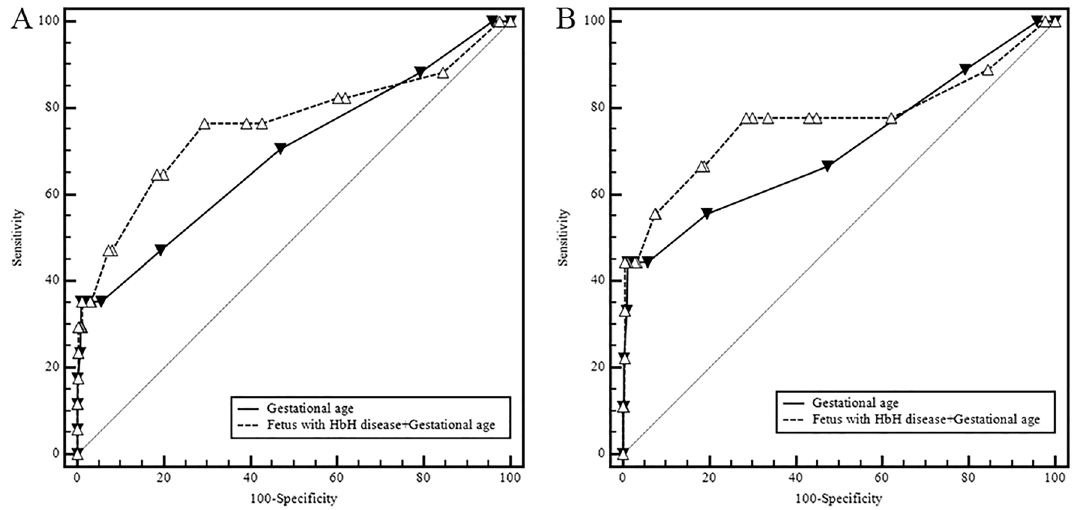
Figure 2. The receiver operating characteristics curves of gestational age alone and its combination with fetal HbH disease in predicting an Apgar score < 7 at 1 ( A ) or 5 ( B ) minutes among thalassemic